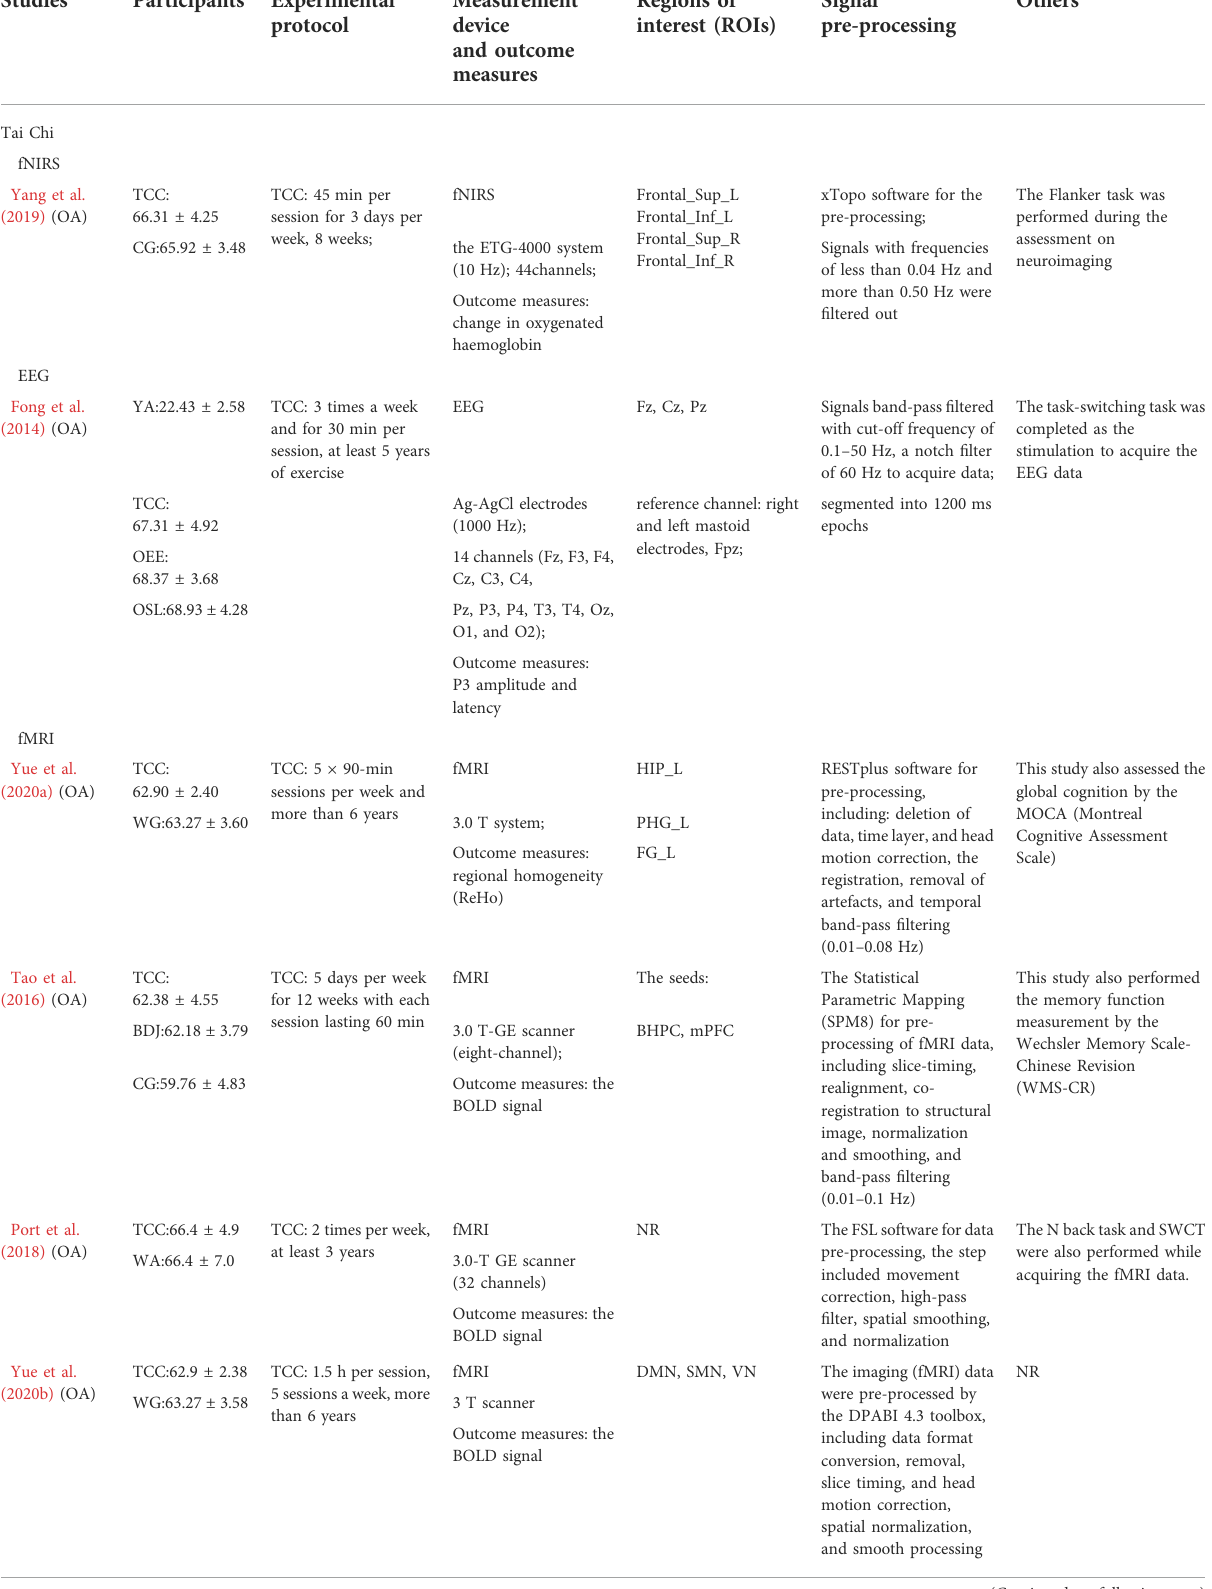
TABLE 2 Characteristics of the studies in healthy older